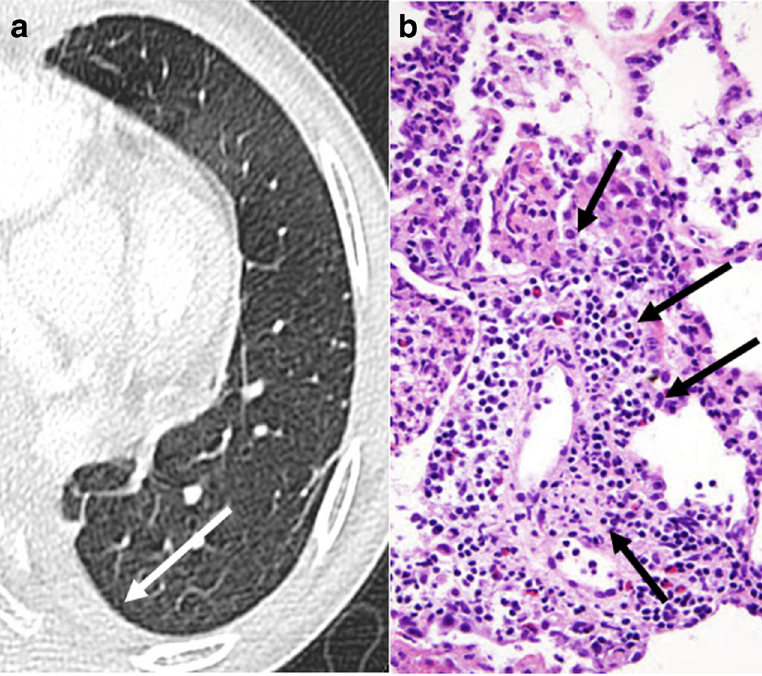
Fig. 9 Acute rejection A3. New pleural effusion ( arrow ) ( a ) as the only finding in moderate acute rejection, histologically defined as dense perivascular mononuclear infiltrates with peribronchiolar and airspaces extension ( arrows ) ( b )